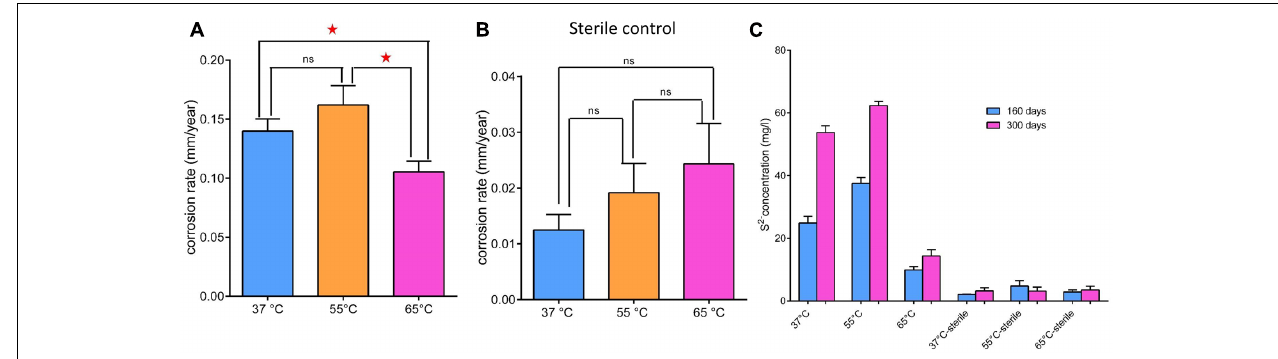
FIGURE 2 | General corrosion rates (A,B) and dissolved sulfide (C) in the aqueous phase of microcosms under 37 ◦ C (blue bar), 55 ◦ C (orange bar) and 65 ◦ C (pink bar) after 28 days incubation. (A) Production water and carbon steel incubated at above temperatures; (B) corresponding sterile controls; (C) dissolved sulfide in the aqueous phase of microcosms after 160 (blue bar) and 300 days (pink bar) incubation. Asterisks indicate that differences among the means represented by the columns are statistically significant ( p < 0.05). ns, no significant difference.